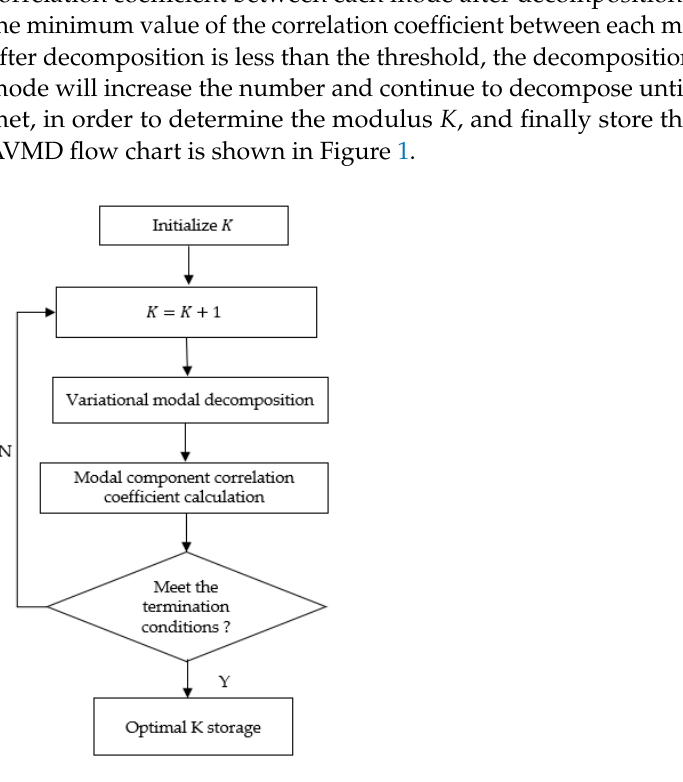
Figure 1. Adaptive Variational Mode Decomposition Process.